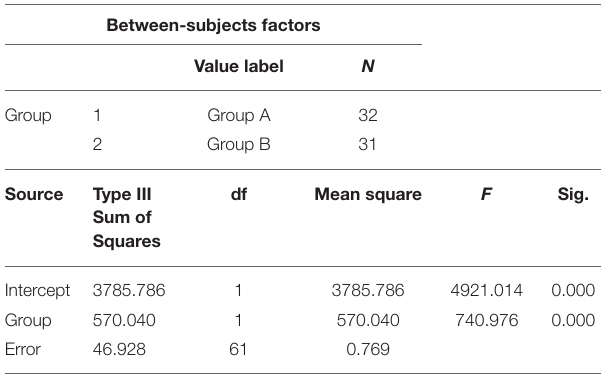
TABLE 3A | Comparison of emotional conditions of two groups after emotional induction (ANOVA).